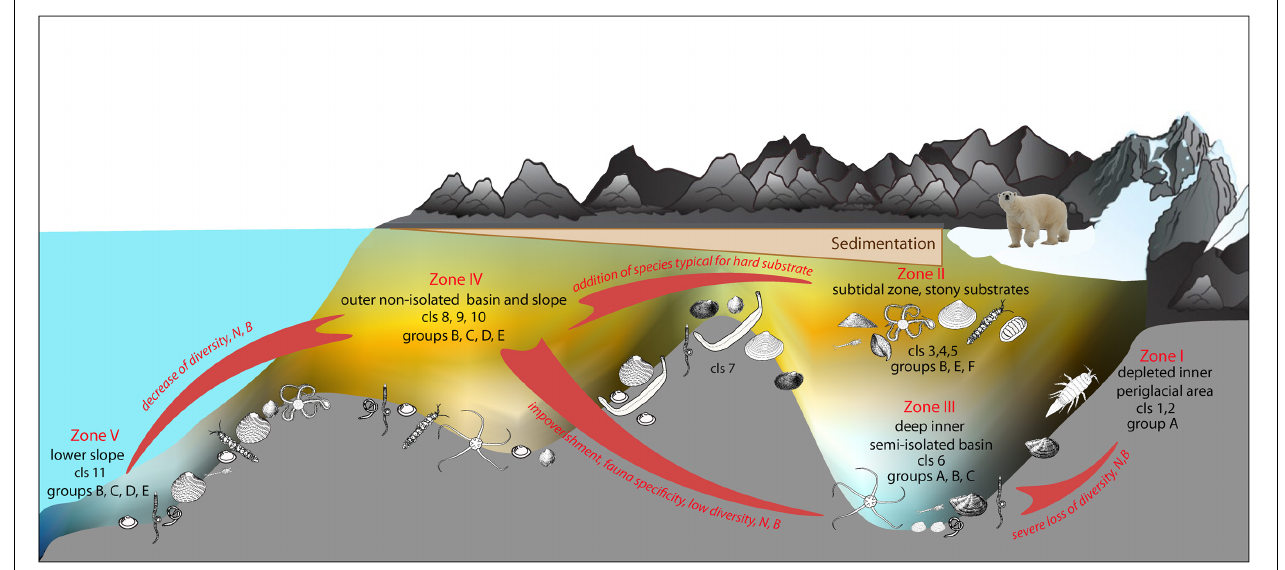
FIGURE 6 | Graphic visualization of benthic communities distribution in high Arctic glacial